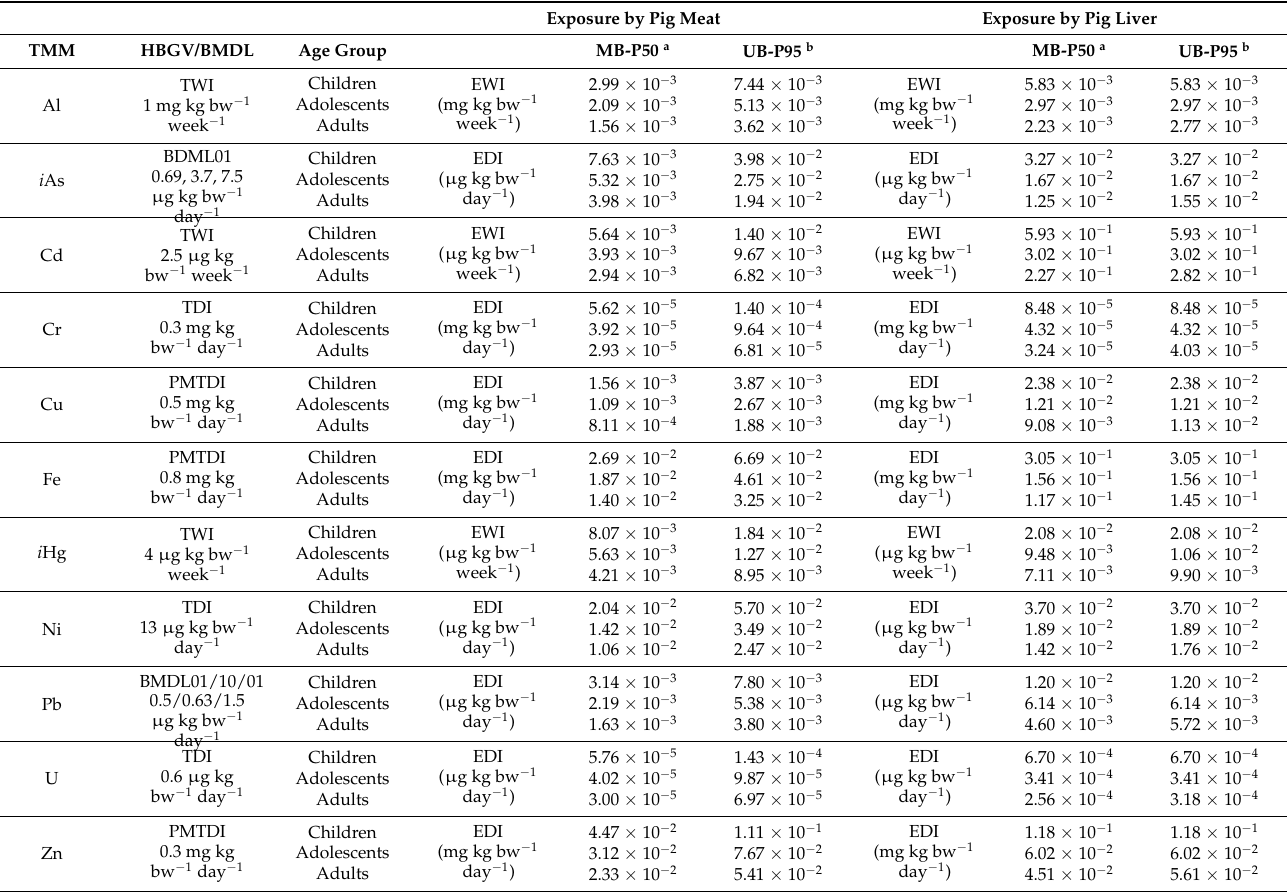
Table 1. Less pessimistic (MB-P50) a and worst-case (UB-P95) b estimated dietary exposure scenar- ios for Italian population to toxic metals and metalloids through pig meat and pig liver chronic consumption and relative HBGV/BMDL values established for each